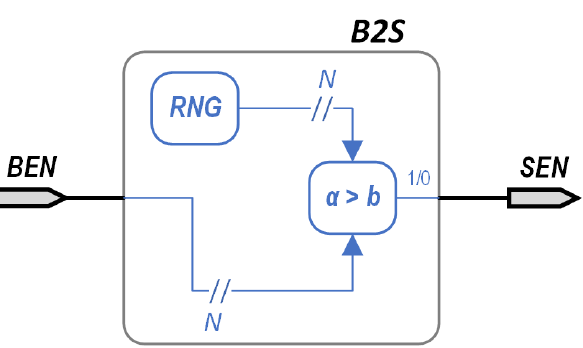
Figure 5. Basic implementation scheme of a Binary Encoded Number (BEN) to a Stochastic Encoded Number (SEN), using a Random Number Generator